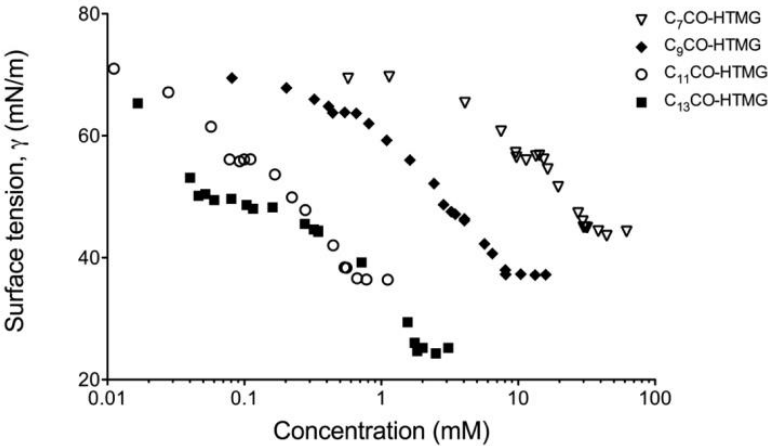
Figure 3. Surface tension ( γ ) isotherms as a function of FA-PILs concentration in aqueous solution at 25 °C. Table 2. Critical micelle concentrations ( cmc ) and surface tension at cmc (γ cmc ) values of the FA-PILs under study.